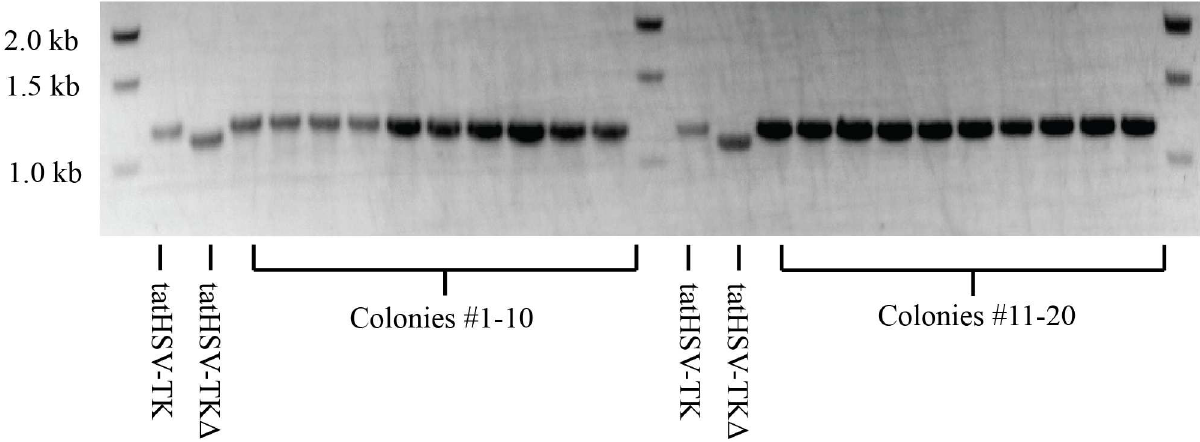
Fig 4. PCR assay demonstrating at least a 10,000-fold enrichment for active tatHSV-TK over an inactive tatHSV-TK Δ . BW14012 cells expressing one of the two proteins were mixed at a 1:10,000 ratio (tatHSV-TK:tatHSV-TKD) ratio. Twenty coloniesformed when 500,000CFUs (determinedunder non-selective conditions) were plated on 40 μ g/ml AZT. PCR-amplified hsvtk genes from these 20 coloniesindicatedthat all twenty containedtatHSV-TK. Expected band sizes of tatHSV-TK and tatHSV-TKD in this PCR assay are 1226 bp and 1160 bp,